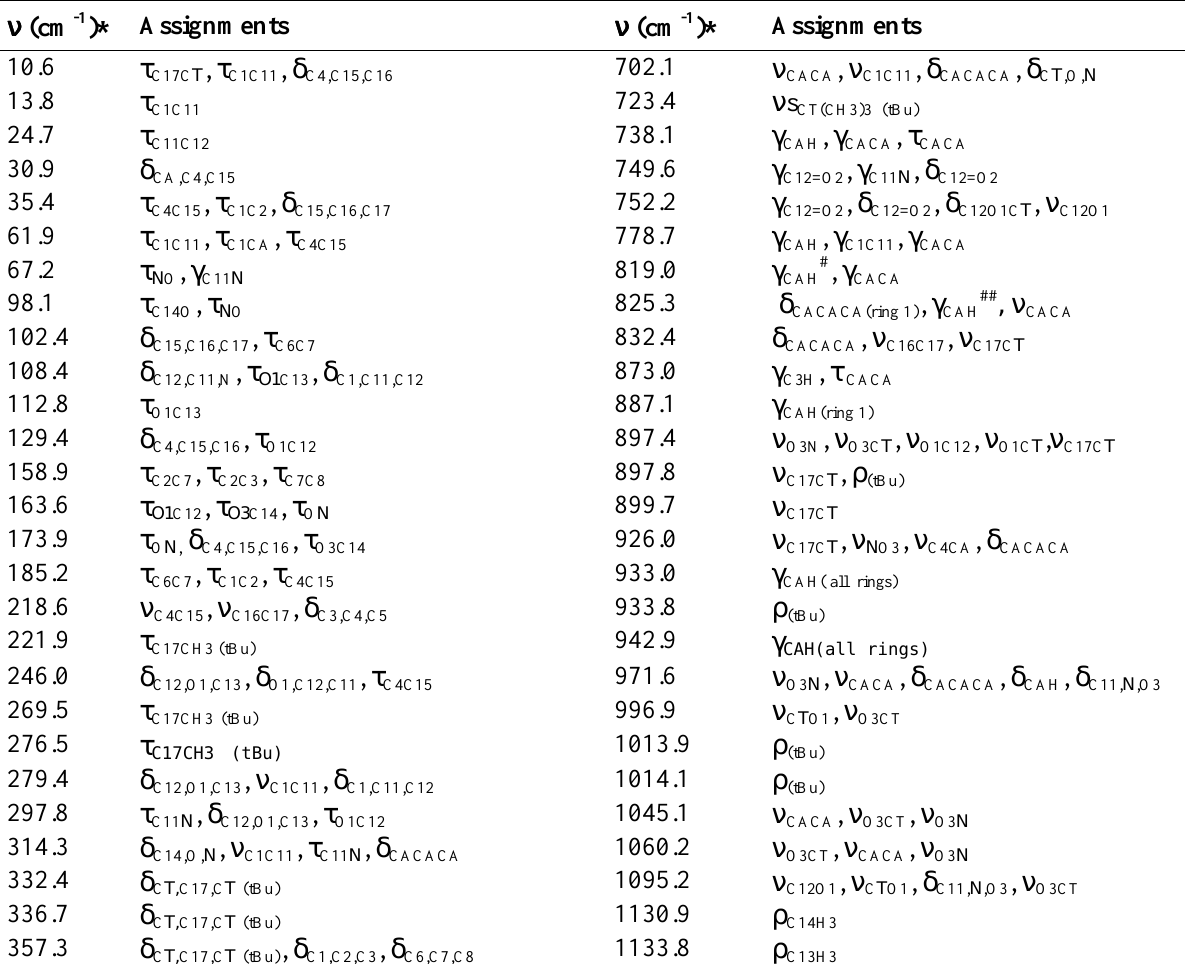
Table 3. Normal modes analysis of RU60358 from DFT (RB3LYP/6-31G (d,